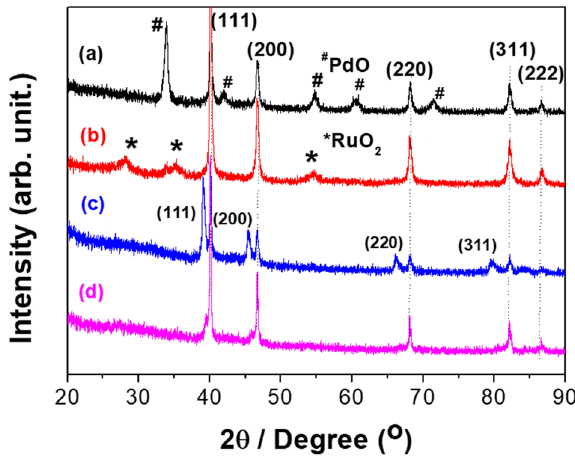
Fig. 1 Thermogravimetric profiles of the developed catalysts